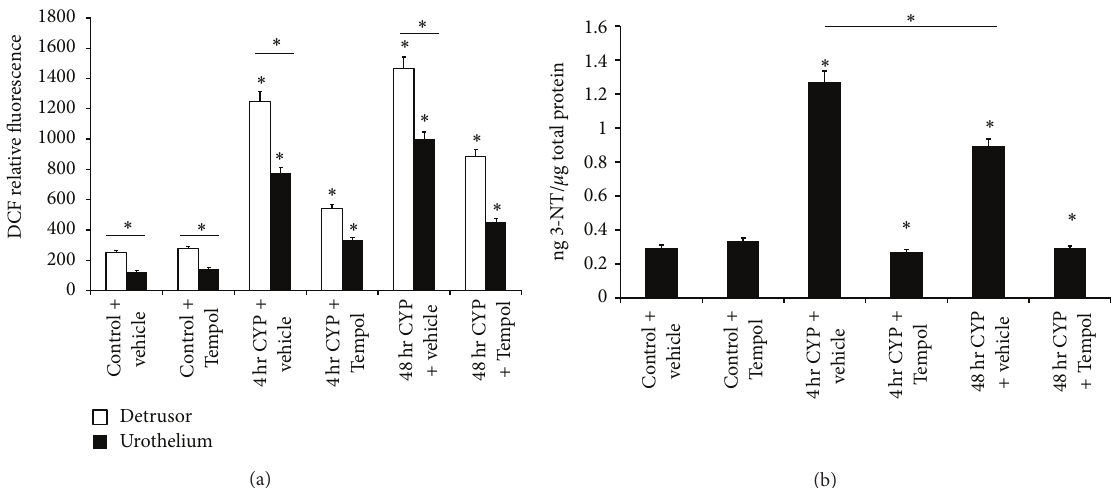
Figure 1: Cyclophosphamide- (CYP-) induced cystitis increases reactive oxygen species (ROS)/reactive nitrogen species (RNS) and 3- nitrotyrosine (3-NT) in the urinary bladder and the antioxidant, Tempol, reduces expression. (a) 4 hr and 48hr CYP-induced cystitis significantly ( 𝑃 ≤ 0.01 ) increased ROS/RNS expression in urothelium and detrusor that was significantly ( 𝑃 ≤ 0.01 ) reduced with Tempol. Basal expression and CYP-induced ROS/RNS expression were significantly ( 𝑃 ≤ 0.01 ) greater in detrusor compared to urothelium. Tempol was without effect on ROS/RNS expression in urothelium and detrusor from control (no CYP) rats. (b) 4hr and 48 hr CYP-induced cystitis significantly ( 𝑃 ≤ 0.01 ) increased ROS/RNS expression in urinary bladder that was significantly ( 𝑃 ≤ 0.01 ) reduced with Tempol. Tempol was without effect on 3-NT expression in urinary bladder from control (no CYP) rats. ∗ 𝑃 ≤ 0.01 . 𝑛 = 6 for control and treatment groups.